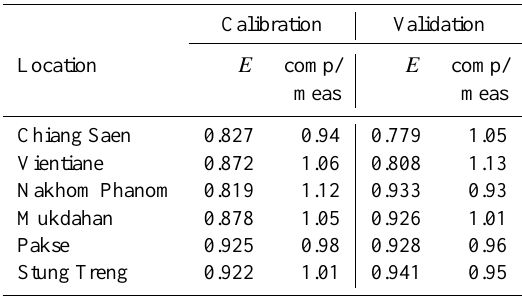
Table 3. Nash-Sutcliffe efficiency coefficient ( E ) and ratio of cumu- lative discharge volumes (computed/measured) for the calibration (1982–1991) and validation (1993–1999) periods simulated with daily time-step. The number of days for the calibration period is 3652, and for the validation period